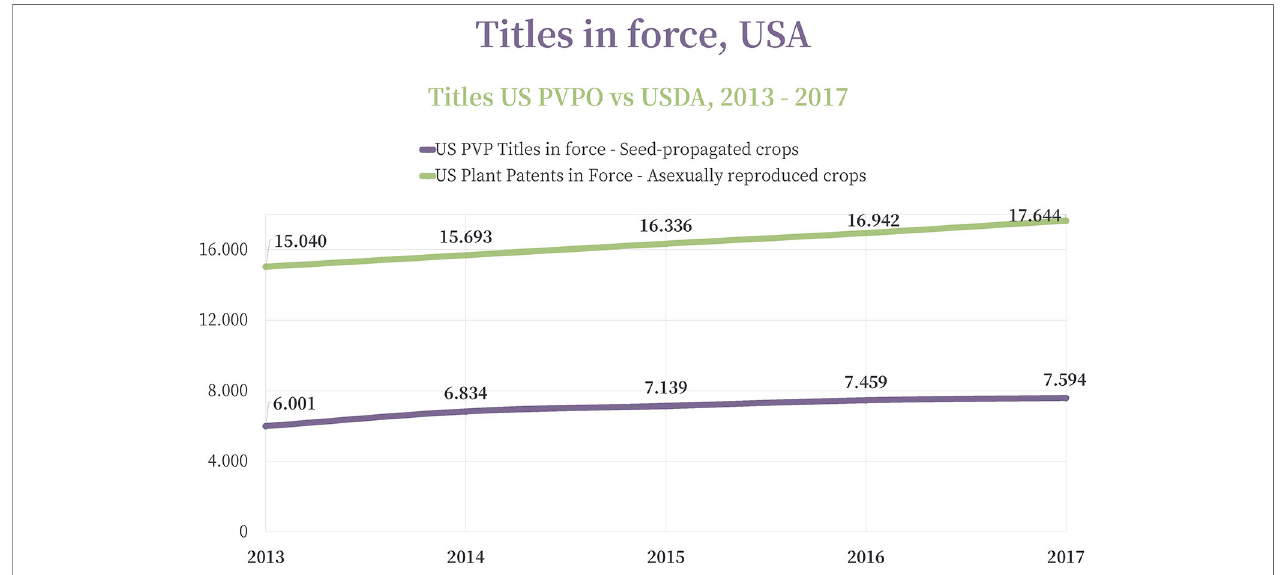
FIGURE 2 | Evolution of the U.S. Plant Variety Rights (PVP) vs. U.S. Plant Patents in force in each consecutive year (2013 – 2017). Source: UPOV,